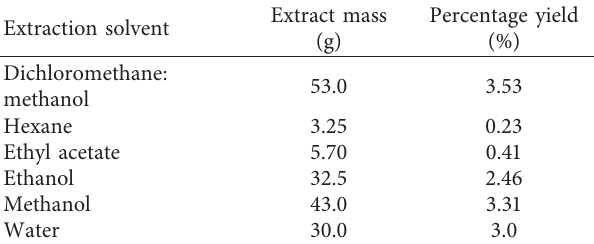
Figure 2: Structure of β -sitosterol. Table 1: Extraction yield of the P. curatellifolia